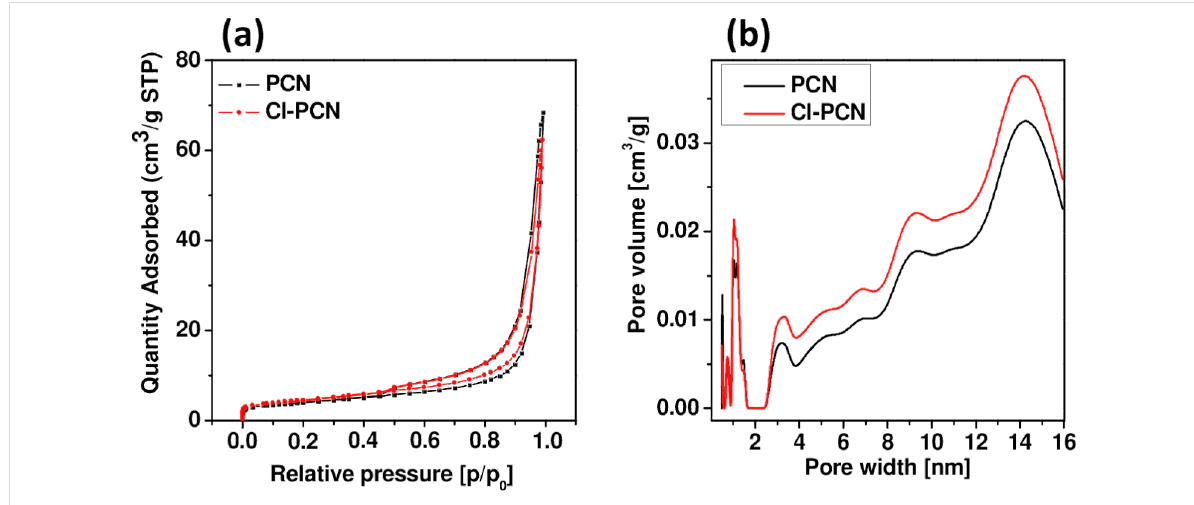
Figure 6: (a) Adsorption–desorption isotherms and (b) density functional theory (DFT) applied to the adsorption isotherms to obtain pore–size distri- butions of PCN and Cl-PCN.